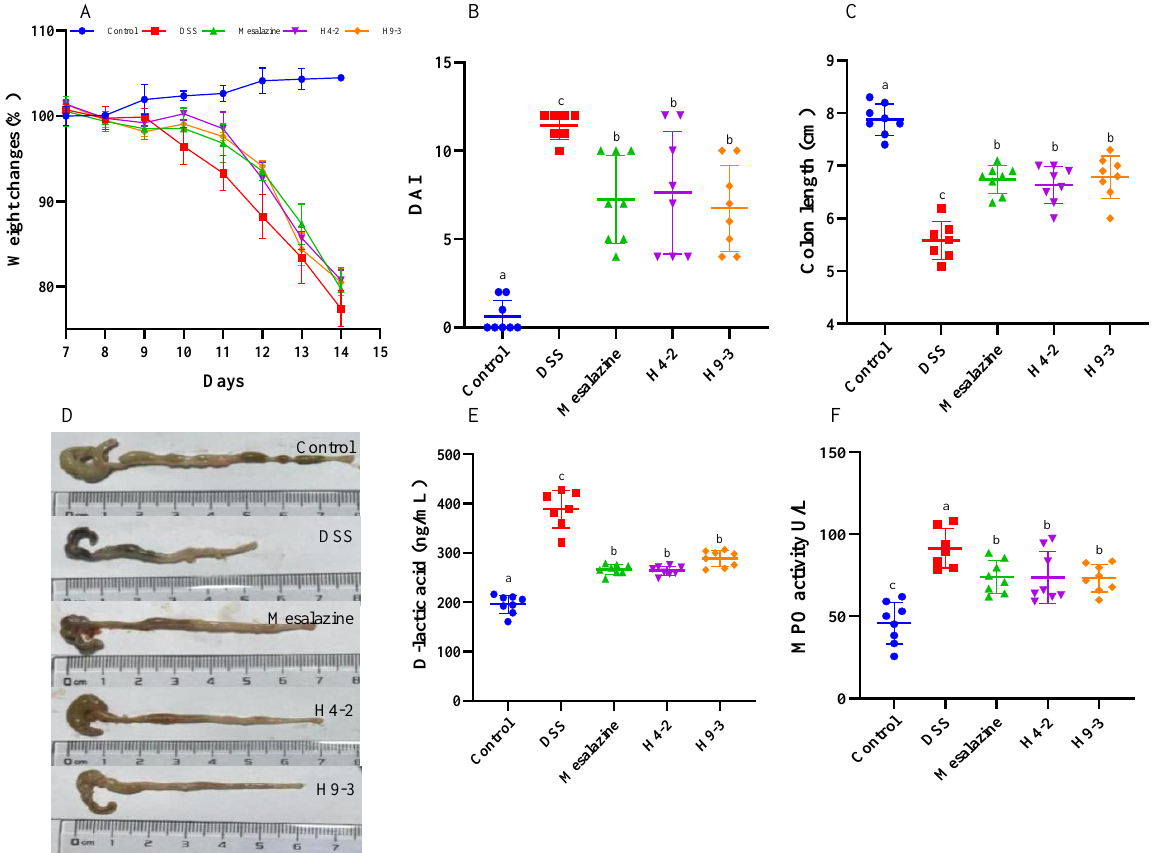
Figure 2. Changes of mice body weight ( A ), DAI ( B ), length of the colon ( C ), macroscopic pictures of colons ( D ), concentration of D-lactic acid ( E ) and activity of MPO enzyme in colons ( F ) after intervention with B. breve . Different lowercase letters (a, b, c) above the columns indicate significant differences ( p < 0.05), and the same superscript letters indicate that the differences between the values are not statistically significant ( p > 0.05).